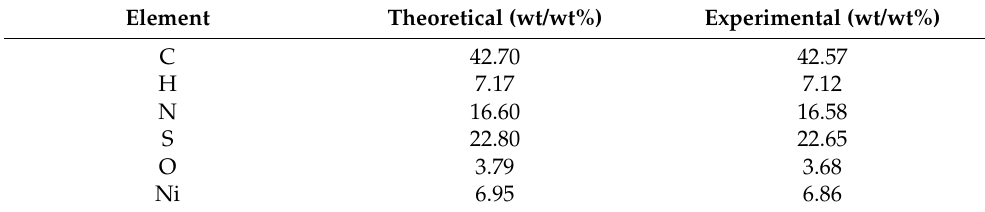
Table 1. Elemental microanalysis for (C 6 H 11 NH 3 ) 4 [Ni(NCS) 6 ] · 2H 2